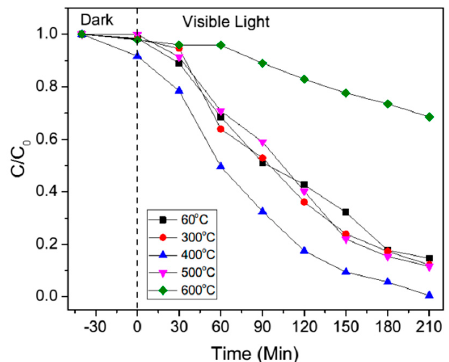
Figure 13. Rate of absorbance of methylene blue dye for BiVO 4 microspheres under calcination temperatures of 60 °C, 300 °C, 400 °C, 500 °C and 600 °C.